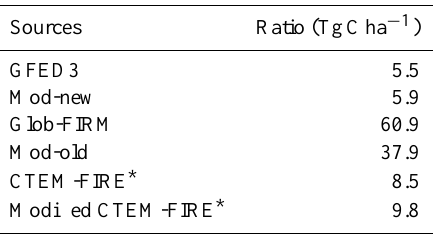
5.5 5.9 37.9 8.5